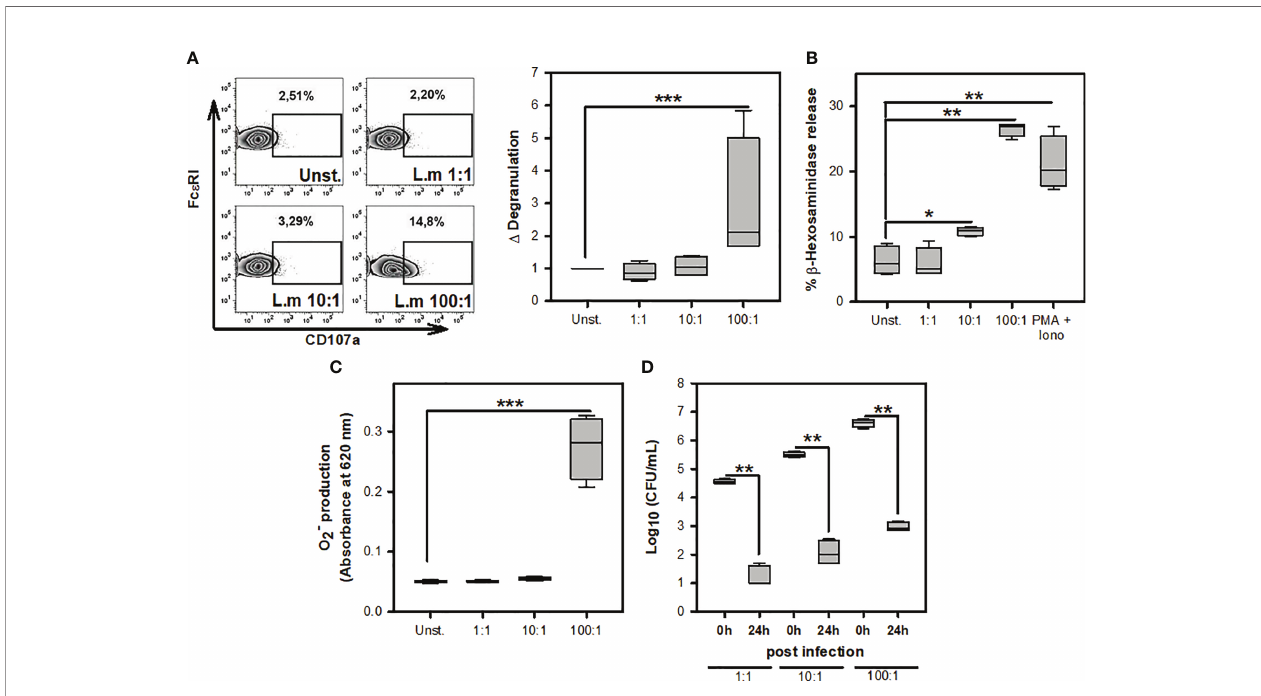
FIGURE 1 | Mast cell activation in response to Listeria monocytogenes infection. (A) 2.5X10 5 BMMC/0.25 mL of complete medium were stimulated with L.m for 90 minutes at the MOI indicated. BMMC degranulation was determined by fl ow cytometry. Left panel shows representative zebra-plots. Right panel shows the fold change in the percentage of Fc ϵ RI + /CD107a + cells with respect to unstimulated MC. (sum of 4 independent experiments, n=4 per group; ***p<0.001; Kruskal-Wallis test). (B) 2.5X10 5 BMMC/0.25 mL of complete medium were stimulated with L.m at the MOI indicated or PMA (125 nM) plus Ionomycin (Iono; 10 m M) for 90 minutes. BMMC degranulation was determined through beta-hexosaminidase release as indicated in Material and methods. (sum of 4 independent experiments, n=4 per group; *p<0.05, **p<0.01 ***p<0.001; Kruskal-Wallis test). (C) 2.5X10 5 BMMC/0.25 mL of RPMI-1640 without phenol red were stimulated with L.m for 2 h at the MOI indicated. Afterwards, the O − 2 determination was performed by the NBT reduction assay. (sum of 4 independent experiments, n=4 per group; ***p<0.001; Kruskal-Wallis test). (D) 2.5X10 5 BMMC/0.25 mL of complete medium were infected with L.m for 2 h at the MOI indicated. Intracellular bacteria were quanti fi ed by CFU assay as indicated in Material and methods. (sum of 4 independent experiments, n=4 per group; **p<0.01; Mann-Whitney